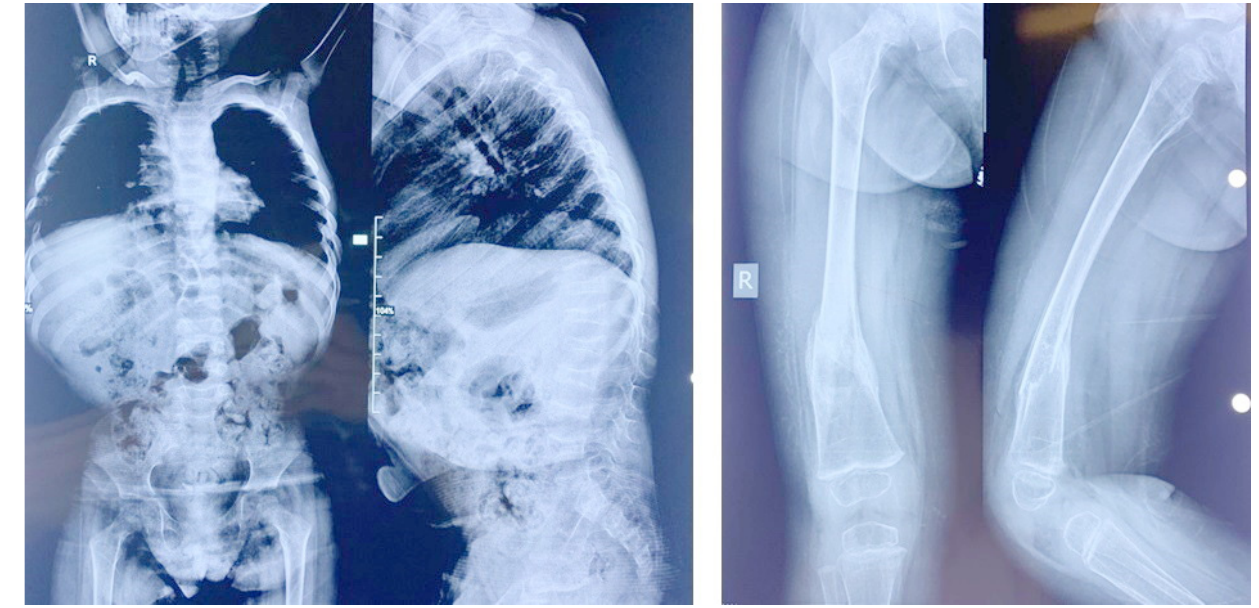
Figure 3. X-rays of patient 2. Note the abnormal lower dorsal and lumbar vertebra and the femoral fracture.